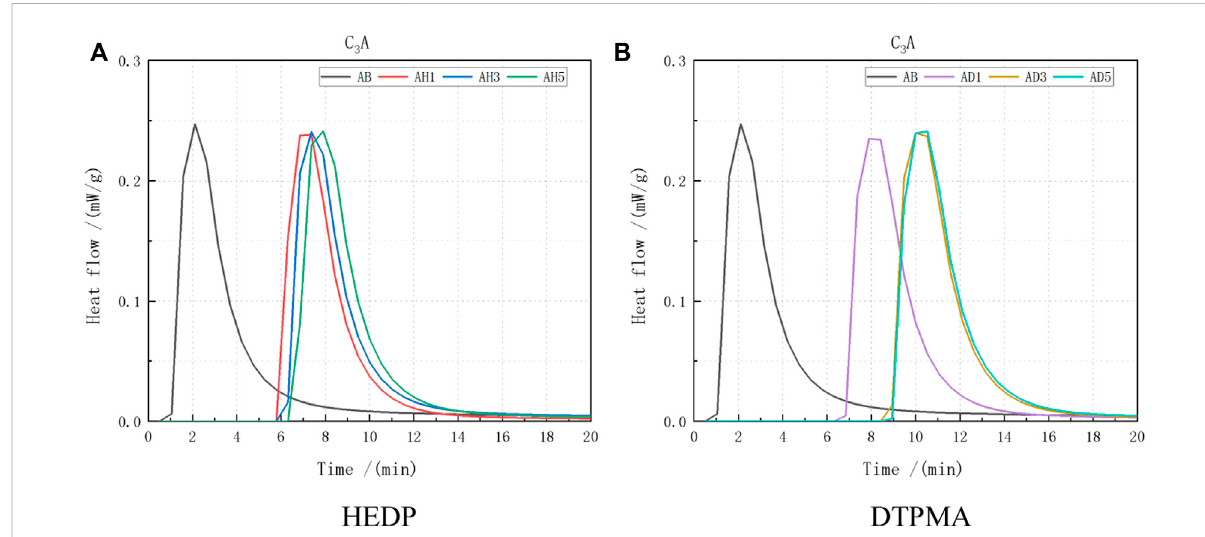
FIGURE 5 Heat fl ow data obtained from C 3 A combined with the following: (A) HEDP and (B) DTPMA.